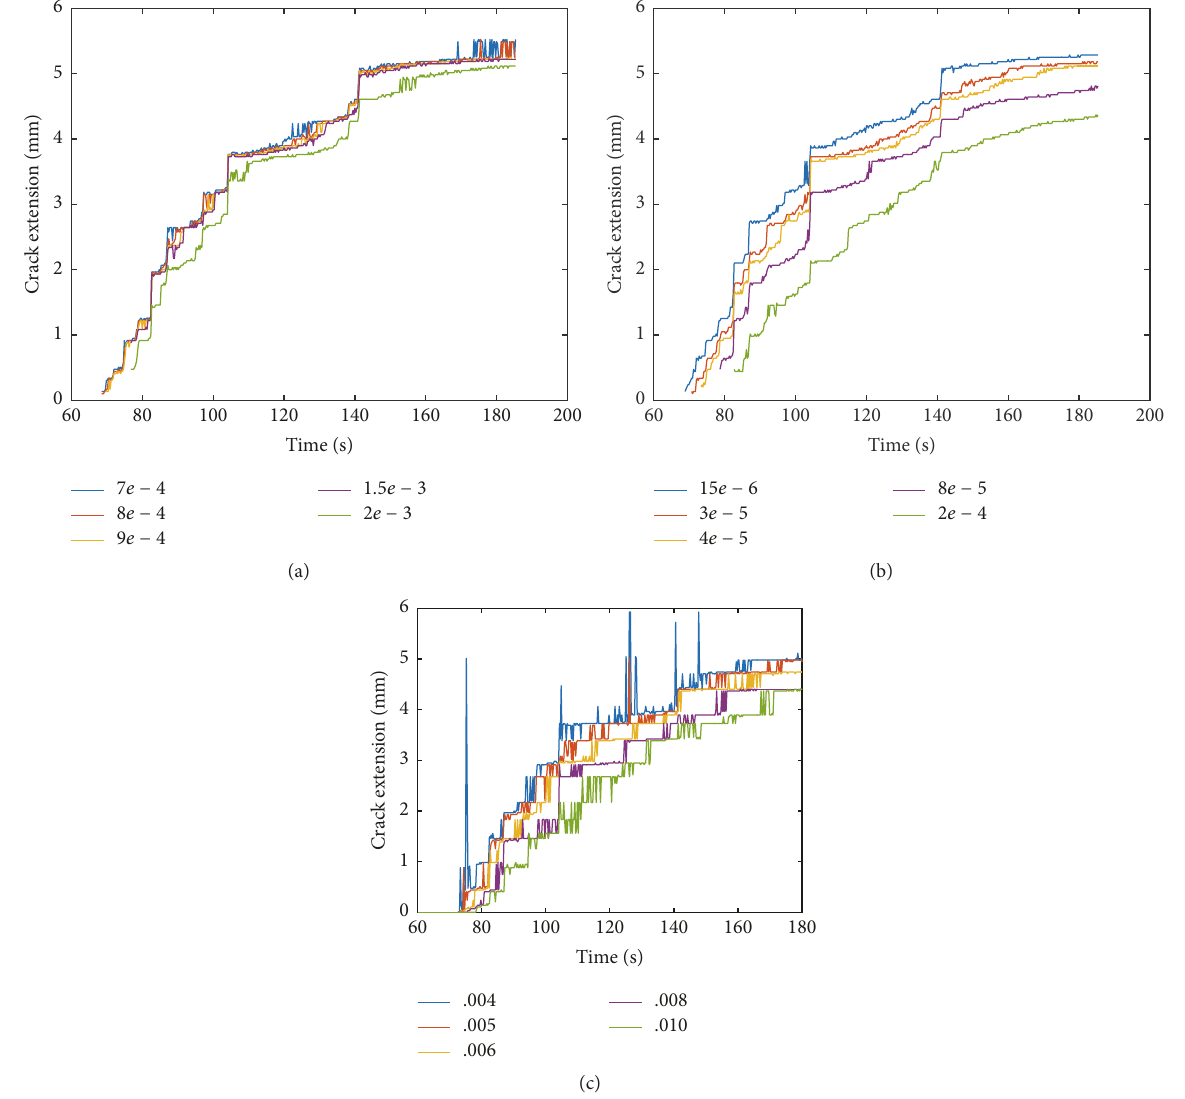
Figure 8: Crack extensions using different threshold parameters based on (a) displacement map with cross-correlation analysis, (b) displacement map without cross-correlation analysis, and (c) strain map without cross-correlation